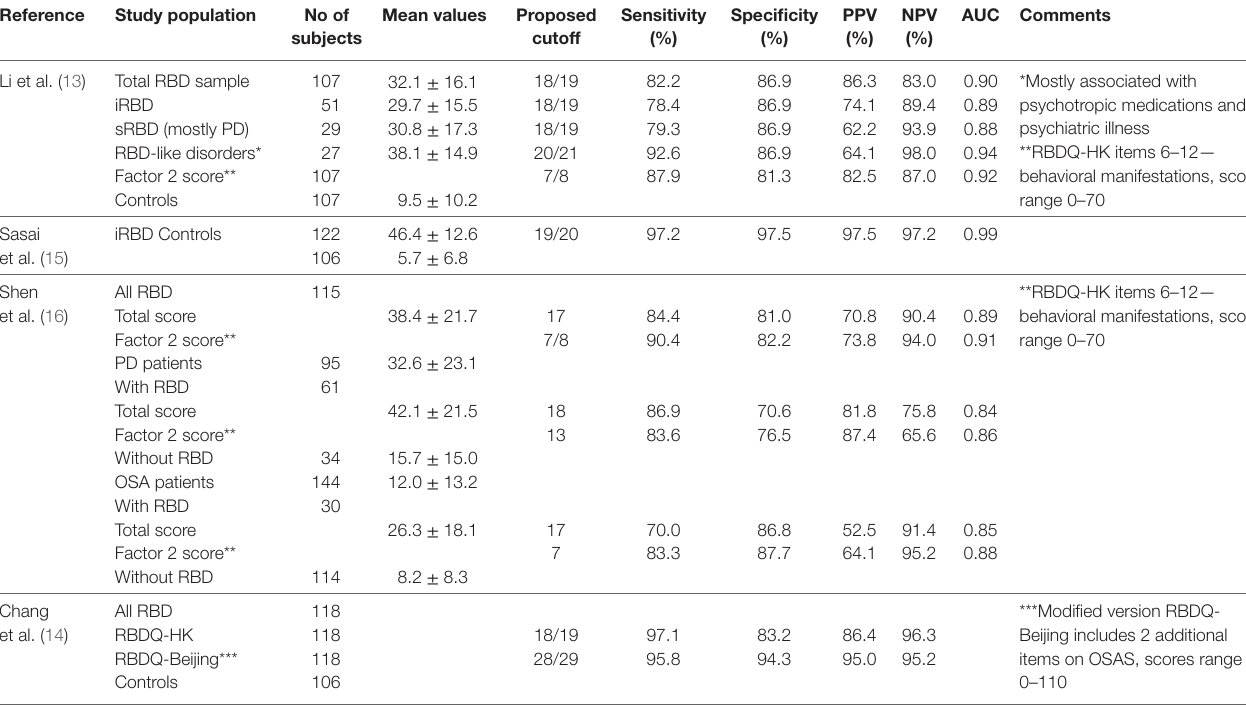
TABle 1 | Diagnostic accuracy of the rapid eye movement (REM) sleep behavior questionnaire (RBDQ-HK). Reference Study population No of